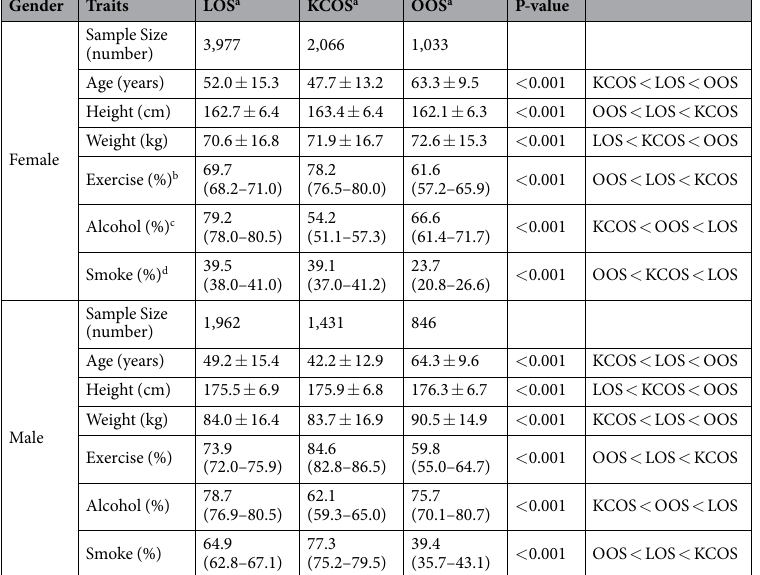
Table 1. Basic characteristic of subjects from LOS, KCOS and OOS. (mean ± SD). Note: a LOS: Louisiana Osteoporosis Study; KCOS: Kansas City Osteoporosis Study; OOS: Omaha Osteoporosis Study. b Exercise is the abbreviation for percentage of subjects who self-reported regular exercise. 95% confidence interval of percentage were reported in the bracket. c Alcohol is the abbreviation for percentage of subjects who self- reported alcohol use. 95% confidence interval of percentage were reported in the bracket. d Smoke is the abbreviation for percentage of subjects who self-reported smoking. 95% confidence interval of percentage were reported in the